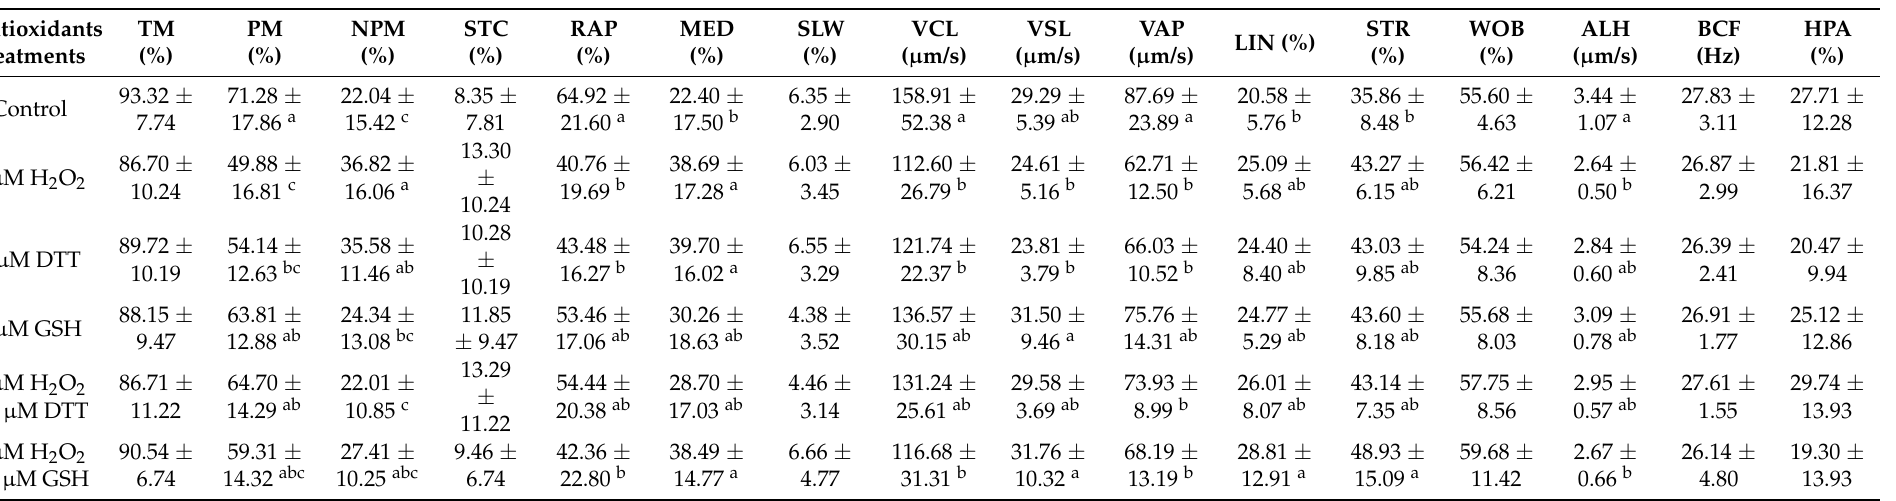
Table 4. Characterization of sperm motility and velocity traits of treated Large White boars’ semen following in vitro liquid preservation under induced oxidative stress (mean ±